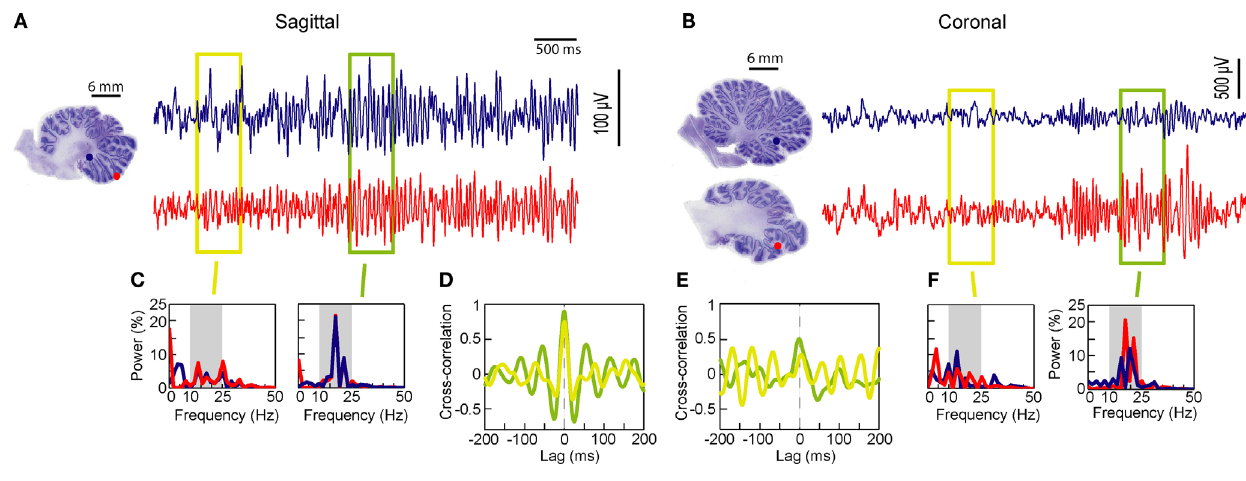
FIGURE 1 | Cerebellar cortex GCL simultaneous LFP recordings at rest, monkey F. (A,B) Simultaneous LFPs recorded sagittally or coronally. Estimated positions of the recording pairs shown, based on reconstruction from electrolytic lesions. Two periods are highlighted, one with low (yellow box) and